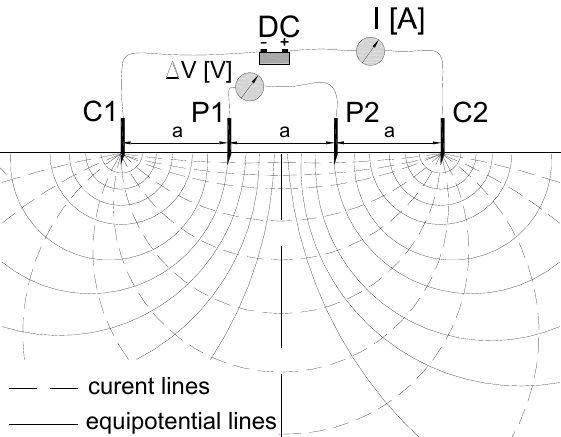
Figure 3. Four-electrode configuration for resistivity measurements, consisting of a pair of current electrodes (C1, C2) and a pair of potential electrodes (P1, P2).